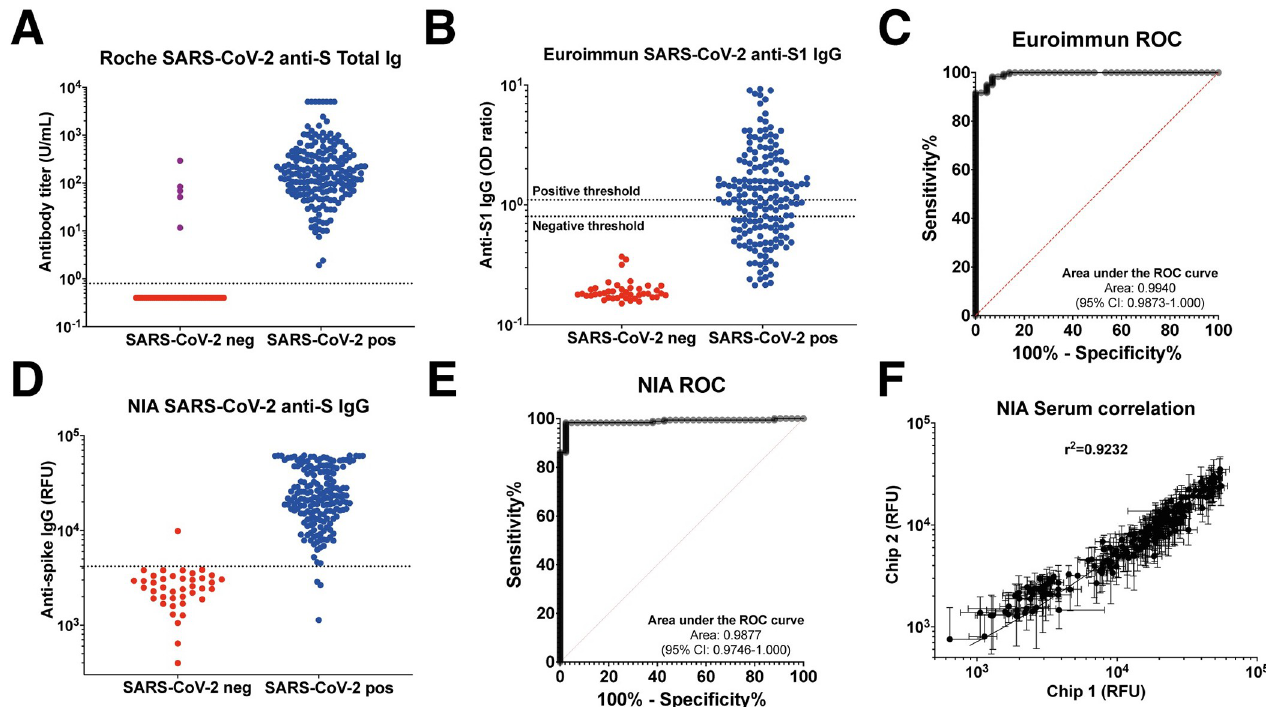
Fig 2. Sample validation with Roche Elecsys, Euroimmun ELISA, and NIA. A) Roche Elecsys anti-SARS- CoV-2 S total Ig assay. 5 SARS-CoV-2 negative samples (purple color) with signal above the positivity threshold ( > 0.8) were excluded from the study. B) Euroimmun ELISA anti-S1 IgG assay. The thresholds for positivity ( > 1.1) and negativity ( < 0.8) classification as provided by the manufacturer are indicated. C) ROC curve with calculated AUC for Euroimmun ELISA. D) NIA measuring inactivated serum samples at 1:8 dilution. E) ROC curve with calculated AUC for NIA. F) Correlation between two different NIA chips (N = 198). Samples with saturating signals ( > 55’000 RFU) were removed from the plot and correlation calculation.